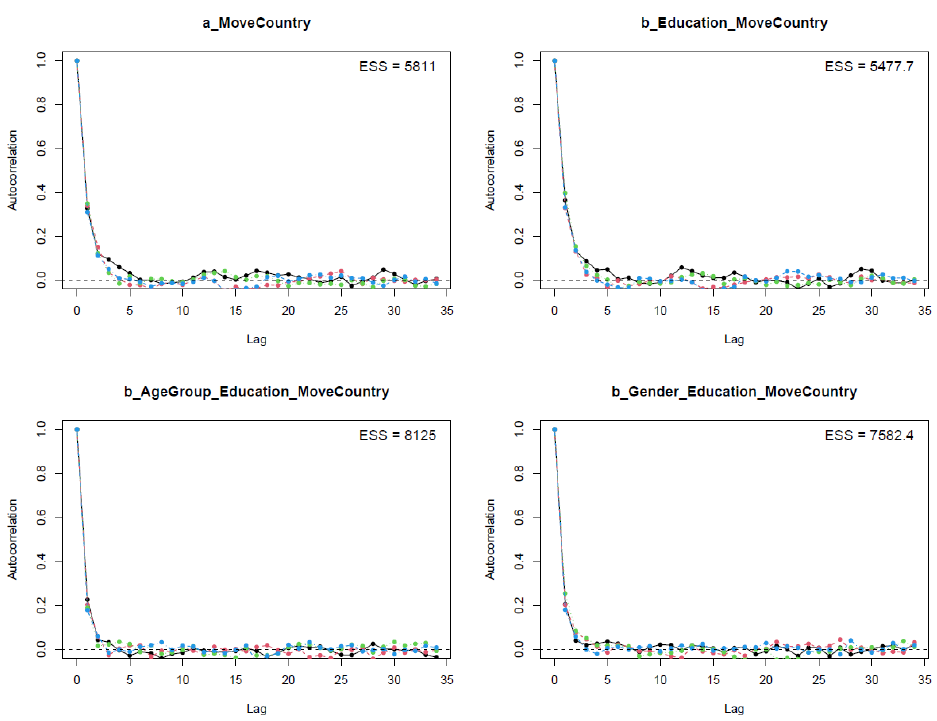
Figure A3. Autocorrelation plots for Model 2′s posterior parameters.